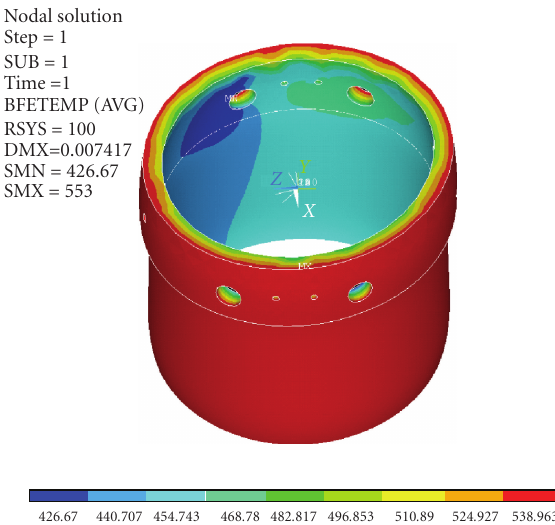
Figure 12: ANSYS: temperature profile imported from CFX at a given time-step.